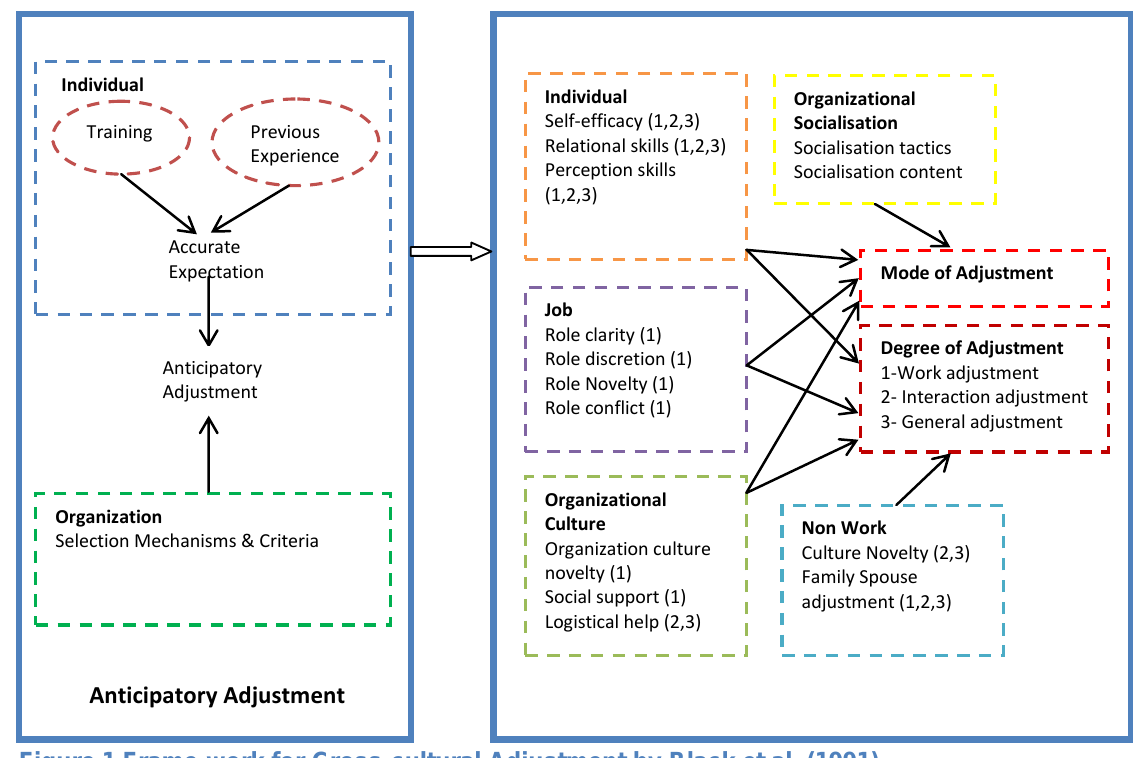
Figure 1 Frame-work for Cross-cultural Adjustment by Black et al.